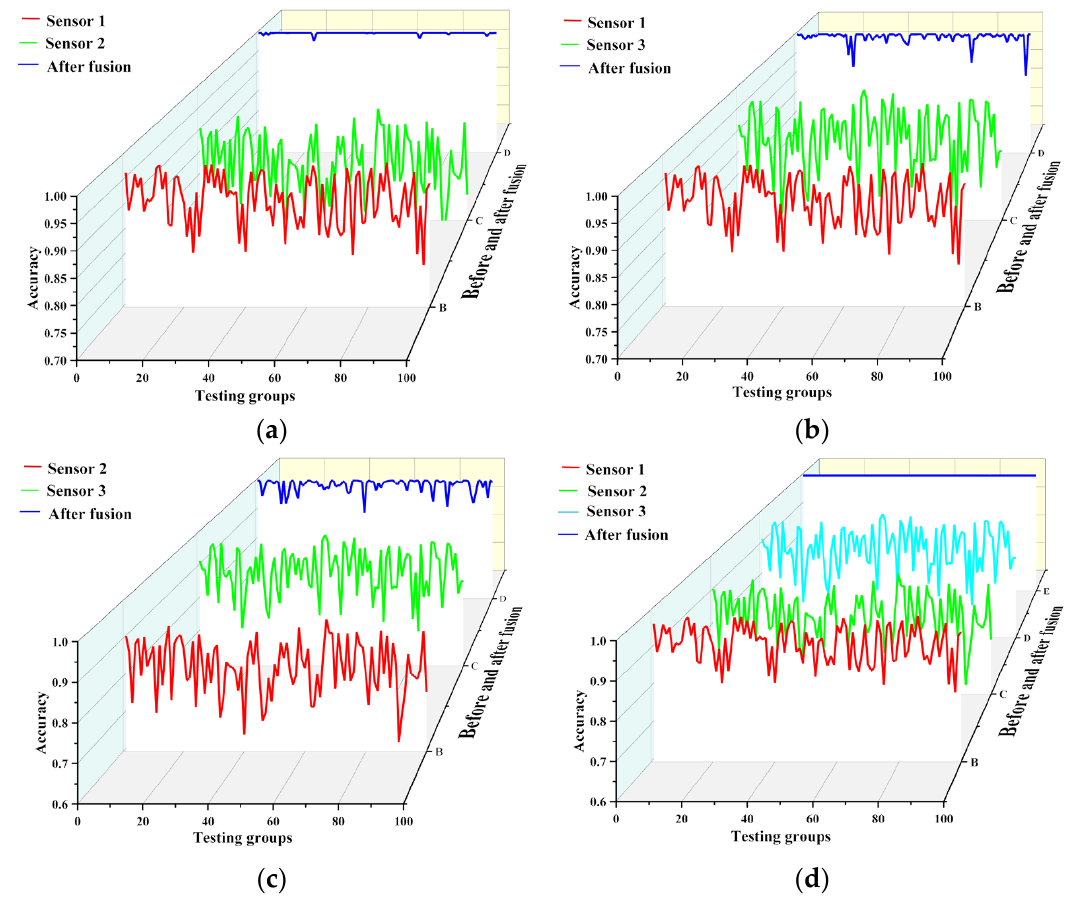
Figure 20. Before and after multi-channel sensor fusion. ( a ) sensor 1 and sensor 2 fusion; ( b ) sensor 1 and sensor 3 fusion; ( c ) sensor 2 and sensor 3 fusion; ( d ) 3 sensors fusion. Table 5. Accuracy comparison before and after multi-channel fusion. Before Fusion After